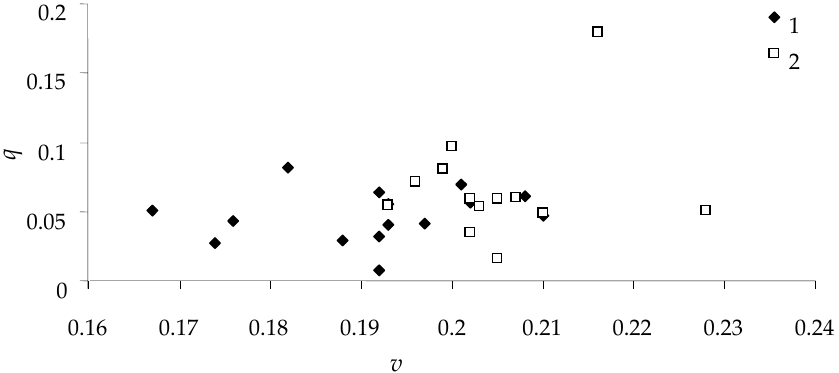
Figure 7. Relations between weight growth rate v and efficiency q of feed consumption for male (1) and female (2) spongy moths.